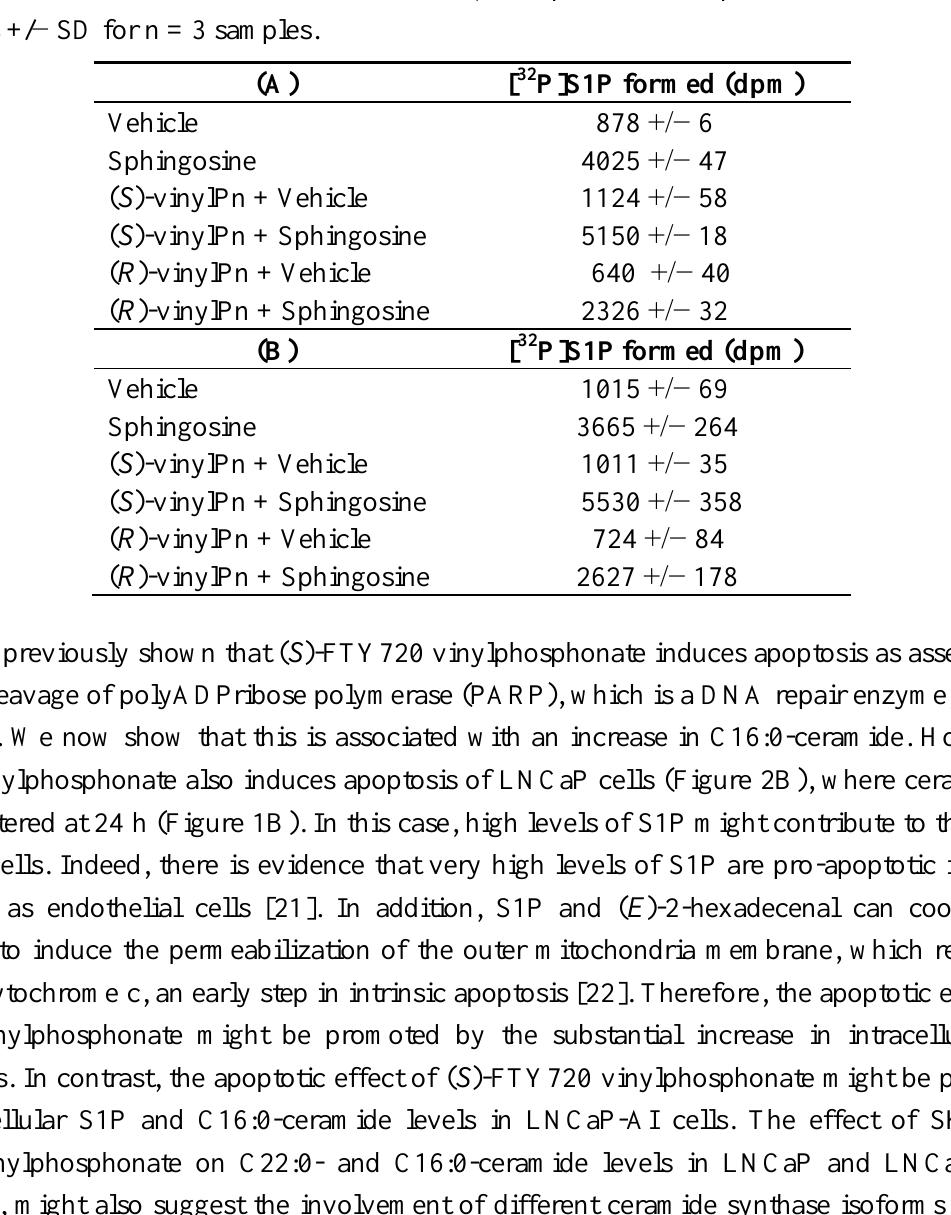
Table 2. The effect of FTY720 vinylphosphonate on S1P formation from sphingosine in human lung endothelial cells. [ 32 P]-labeled cells were treated with sphingosine (2 μM) for 30 min. Cells were preteated with either 10 μM ( S )-FTY720 vinylphosphonate (( S